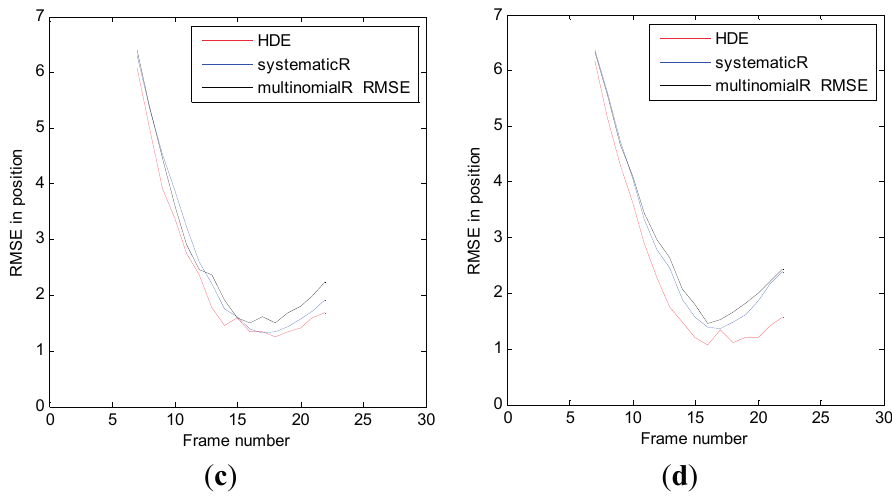
Figure 6. ( a ) RMSE in position at SNR = 9 dB for the CT model; ( b ) RMSE in position at SNR = 6 dB for the CT model; ( c ) RMSE in position at SNR = 3 dB for the CT model; ( d ) RMSE in the position of existence at SNR = 1 dB for the CT